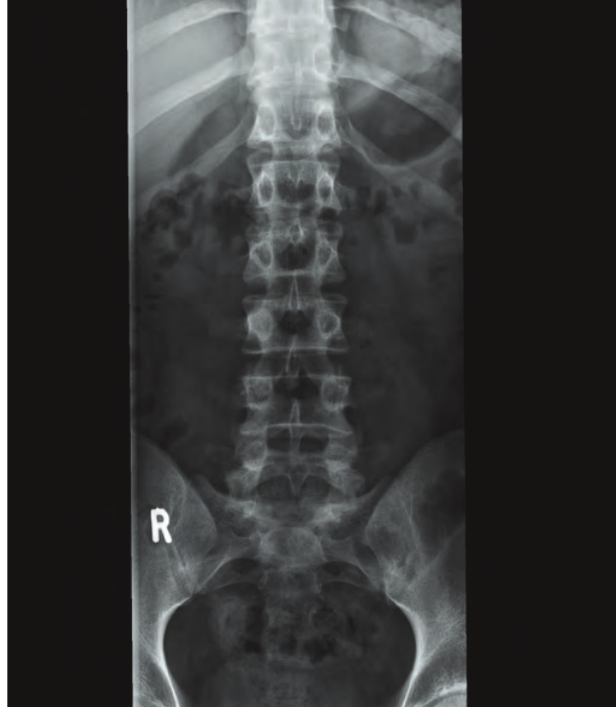
Fig. 1. AP lumbar radiograph. Note the subtle isolated sclerotic change to the right L3